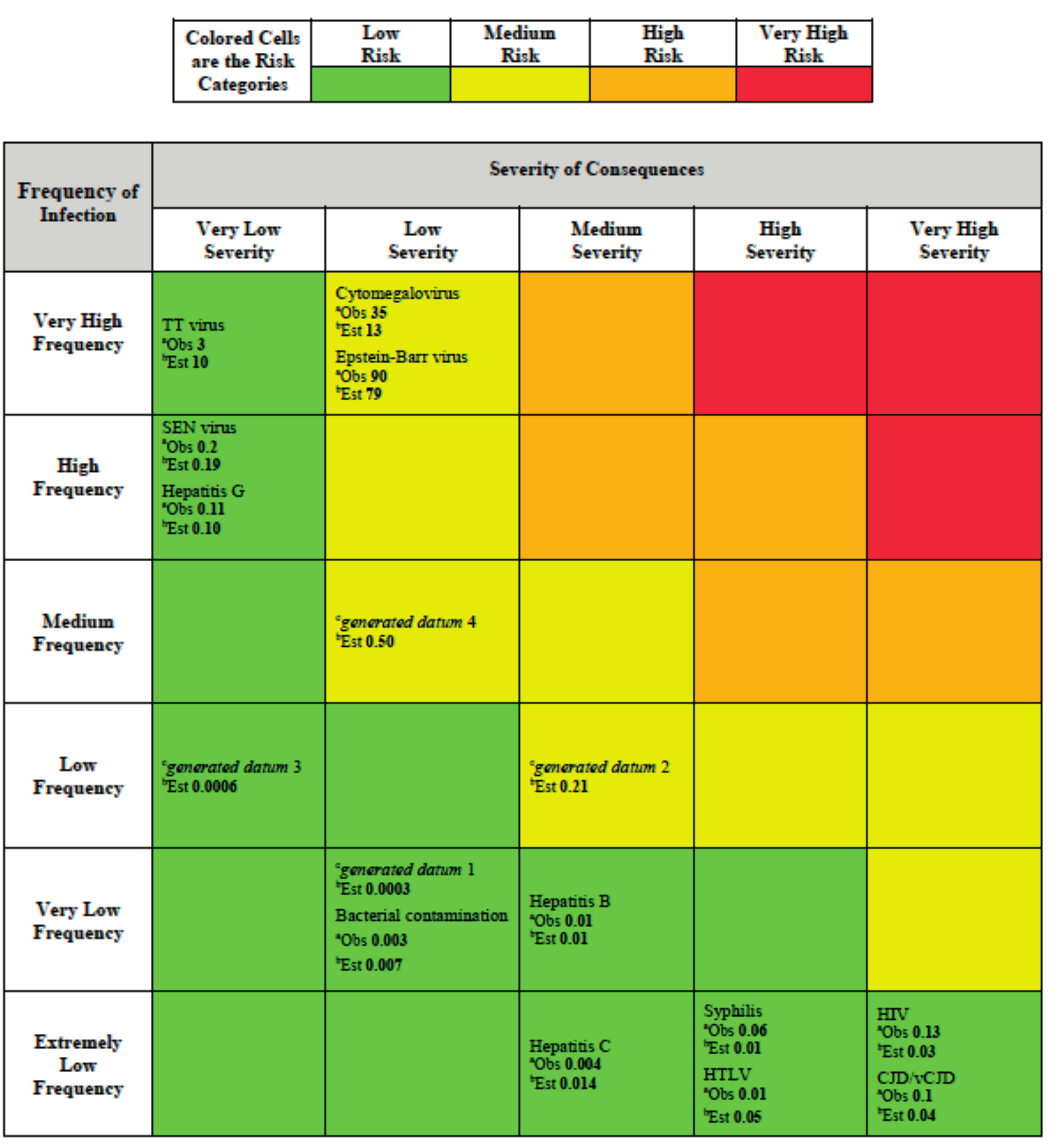
Figure 5. Risk assessment matrix providing colored risk categories plus observed and estimated risk and generated data. a Observed ( Obs ) risk numbers shown are based on the generic risk function (Risk = Frequency × Severity; Equation (1)) and using Table 1 entries frequency and severity using Table 2 data; b Estimated ( Est ) risk numbers shown are based on the fitted risk function Equation (4); c Generated